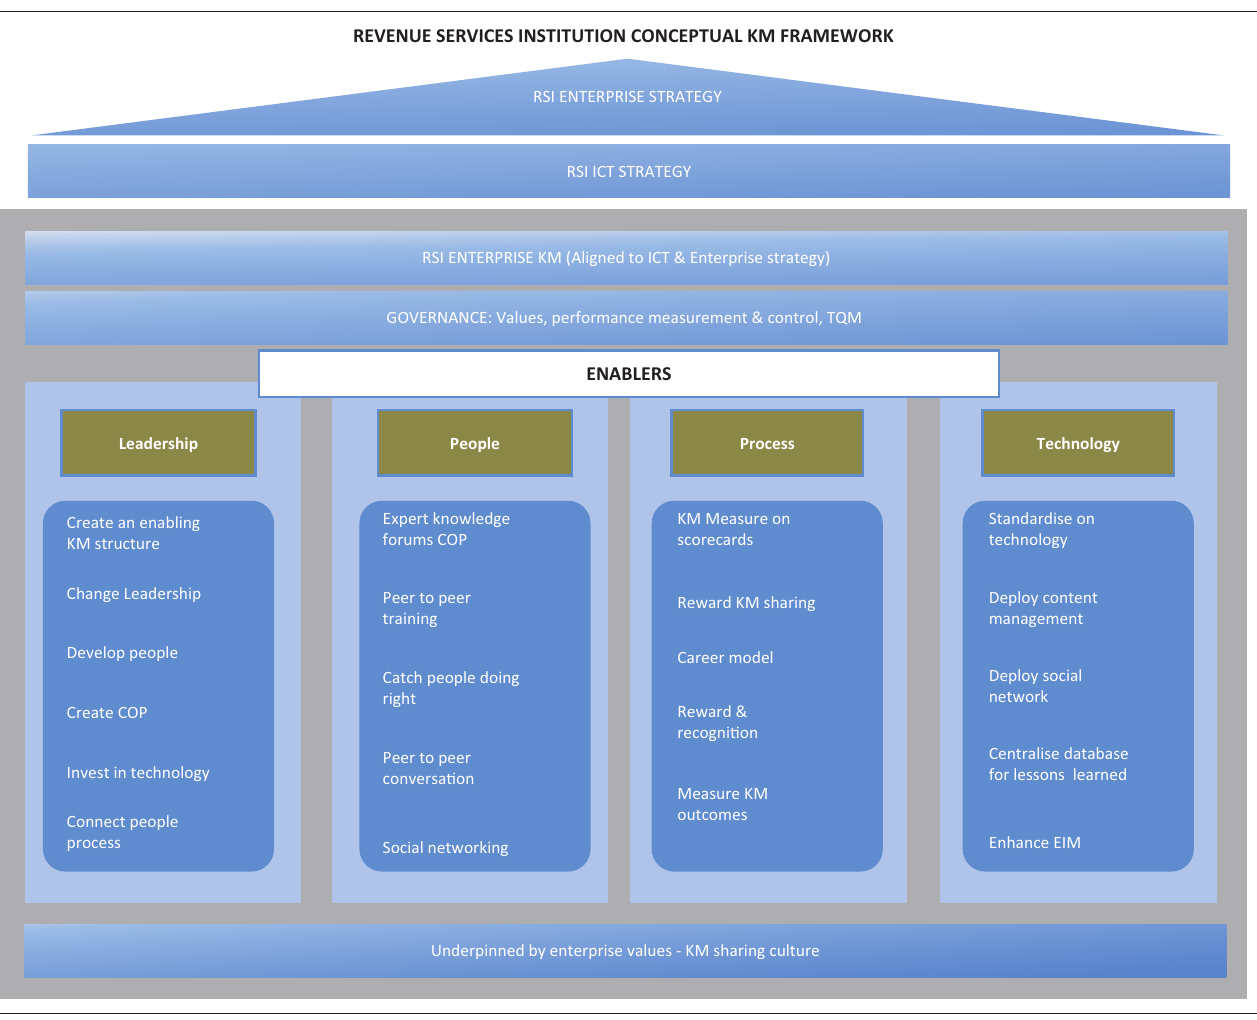
FIGURE 8: Conceptual knowledge management framework for a revenue services